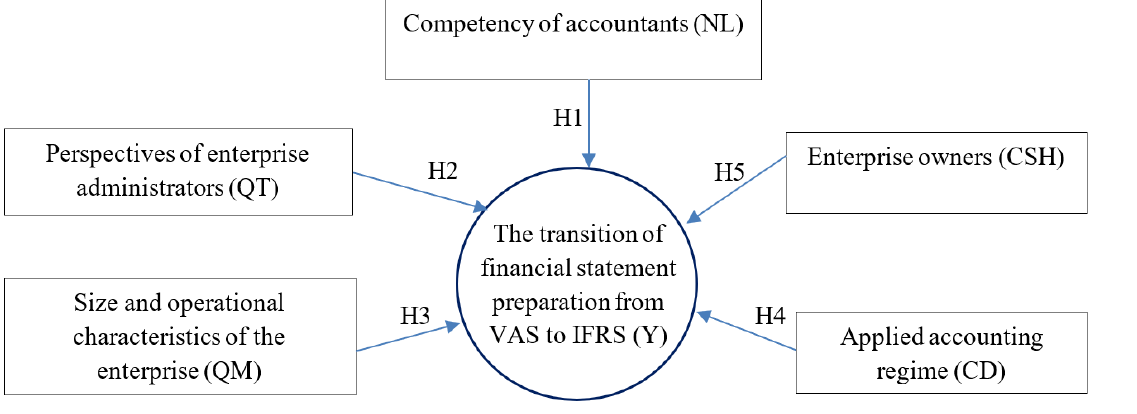
Fig. 2. Overview of the research